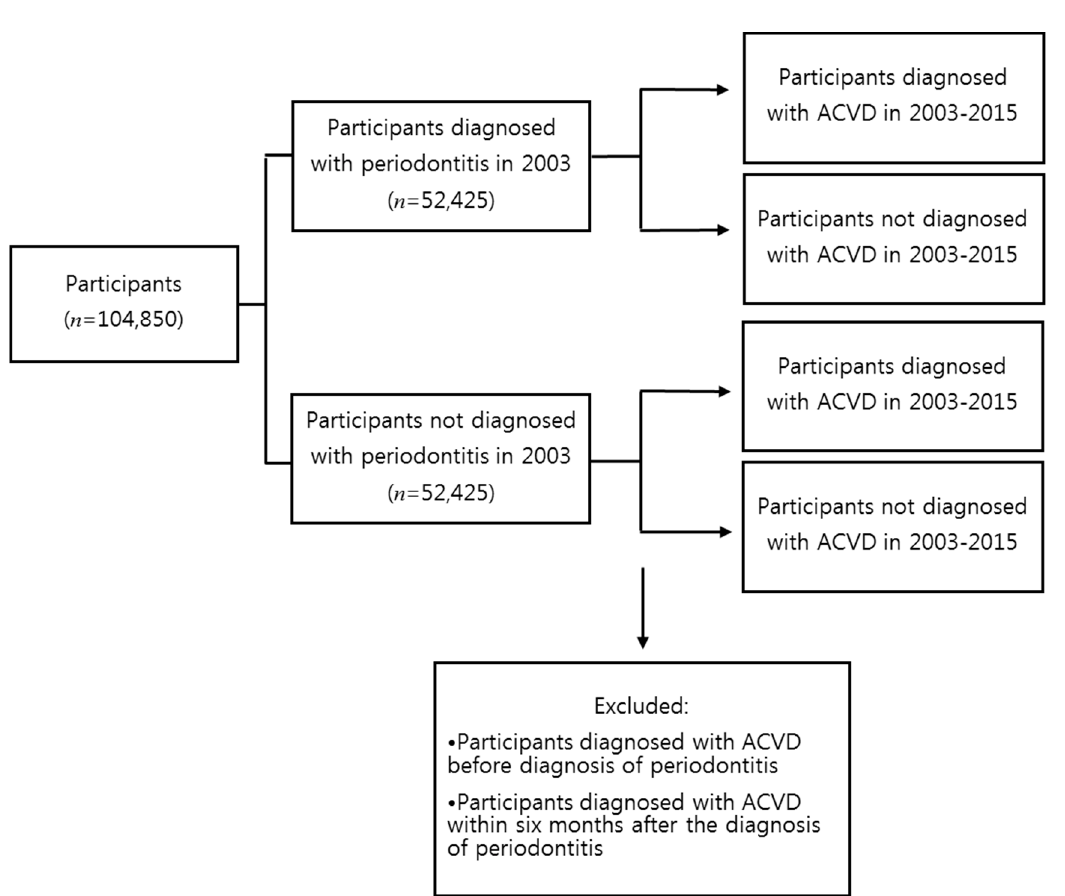
Figure 2. Process of selecting participants diagnosed with ACVD. ACVD: atherosclerotic cardiovascular disease.